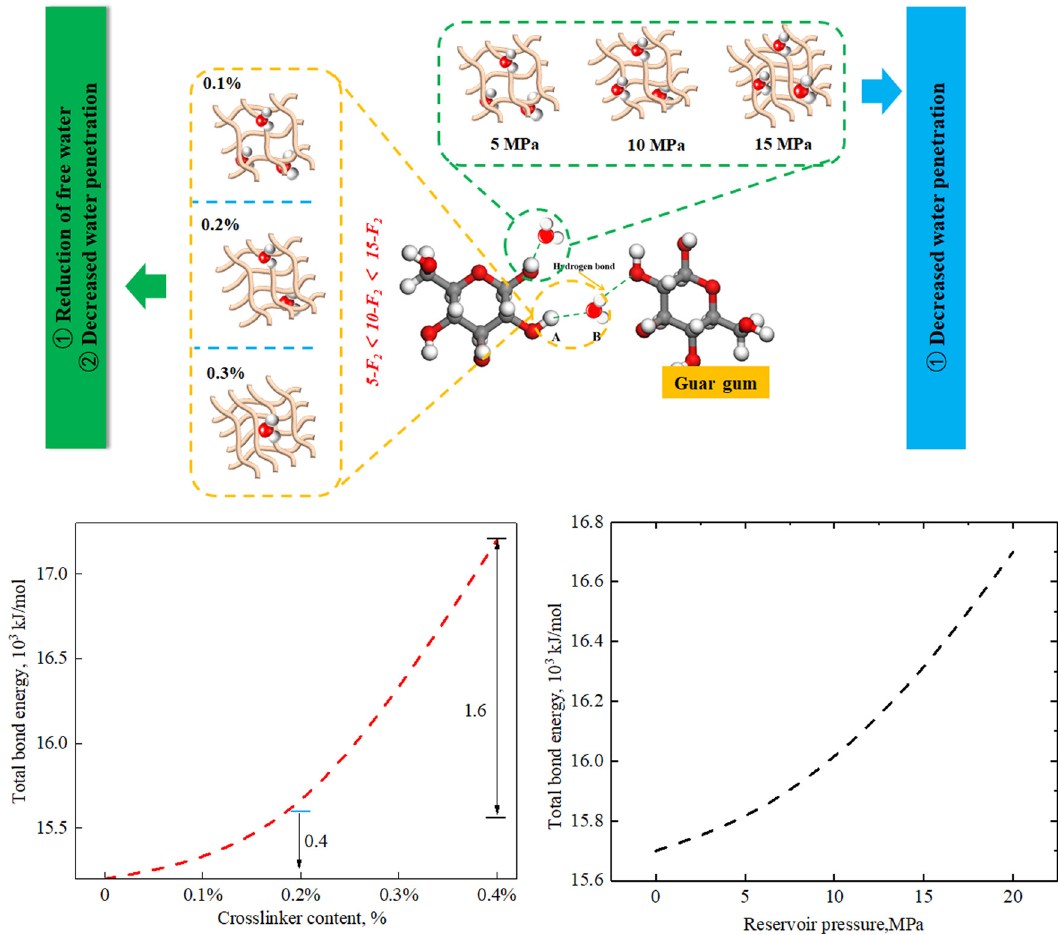
Figure 12: The fi ltration mechanism of guar gum fracturing fl uid changes due to changes in content and